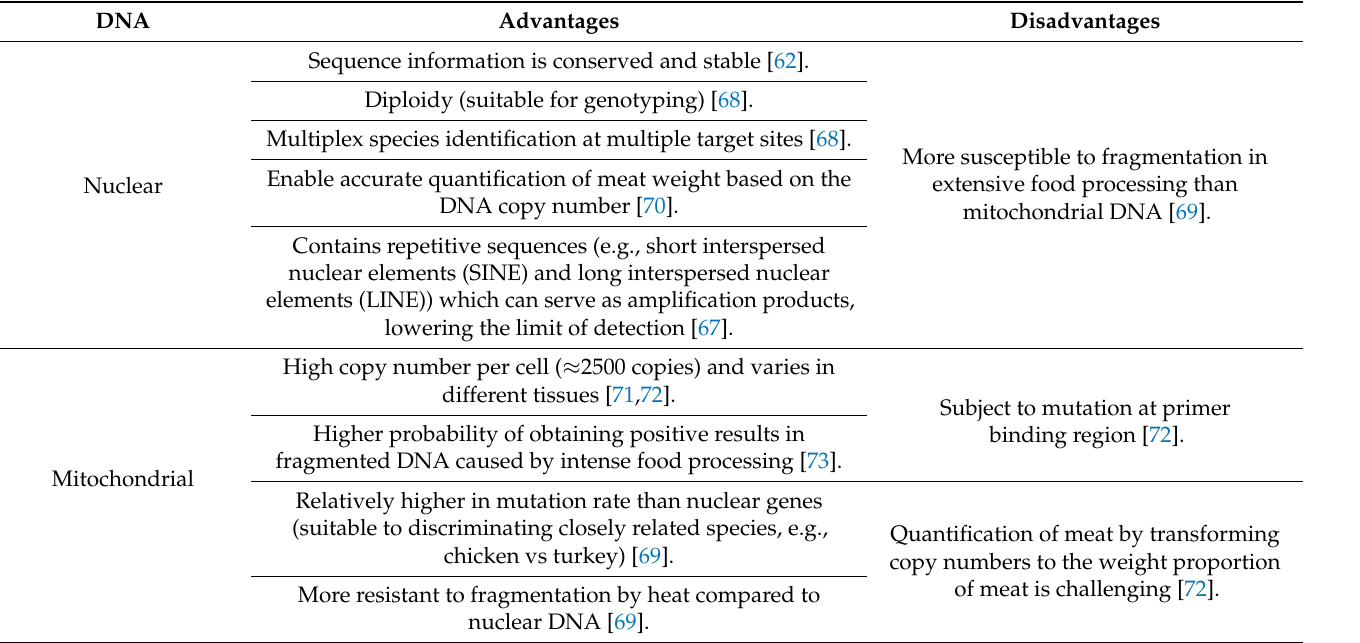
Table 2. A summary of advantages and disadvantages of nuclear and mitochondrial DNA in muscle food origin identification. DNA Advantages Disadvantages